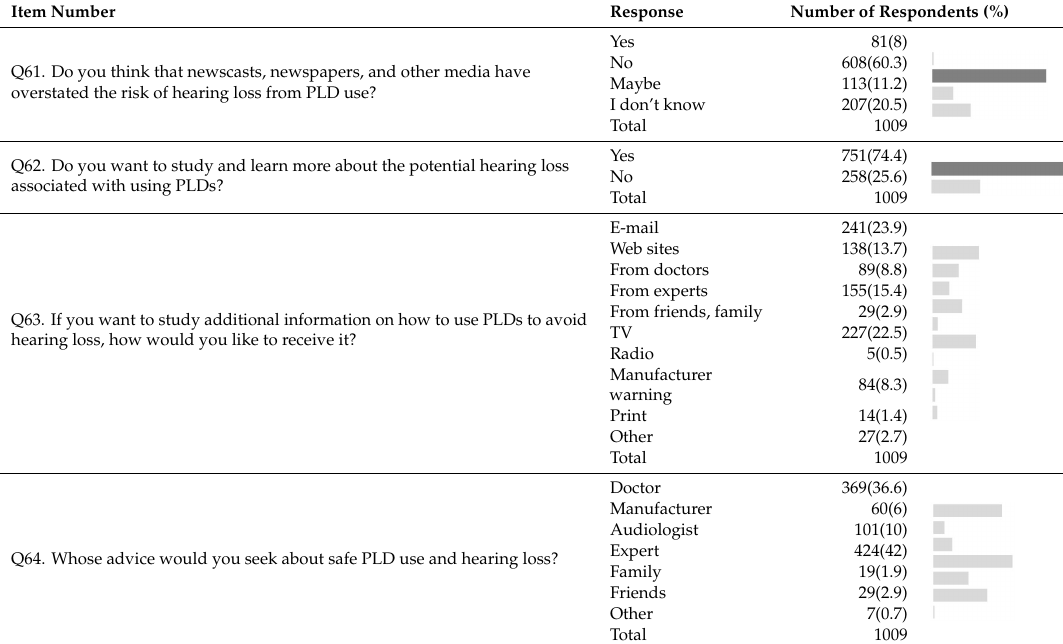
Table A9. Type of education preference for hearing